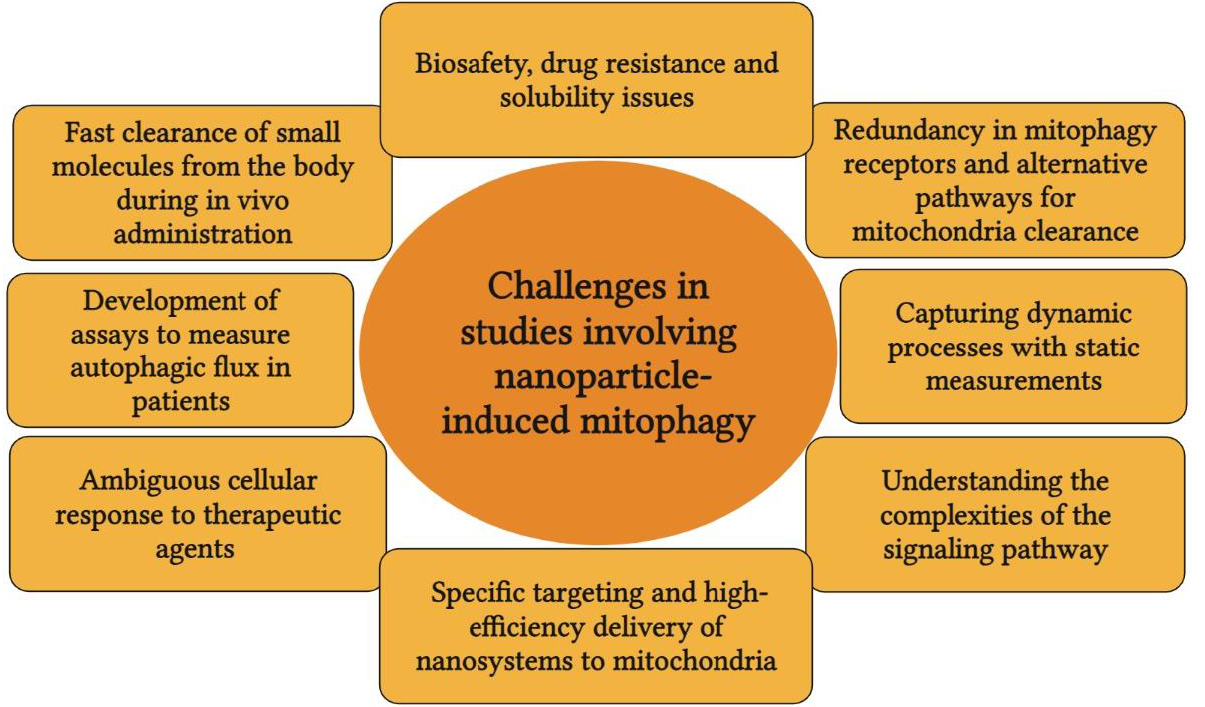
Figure 5. Challenges in studies involving nanoparticle-induced mitophagy.